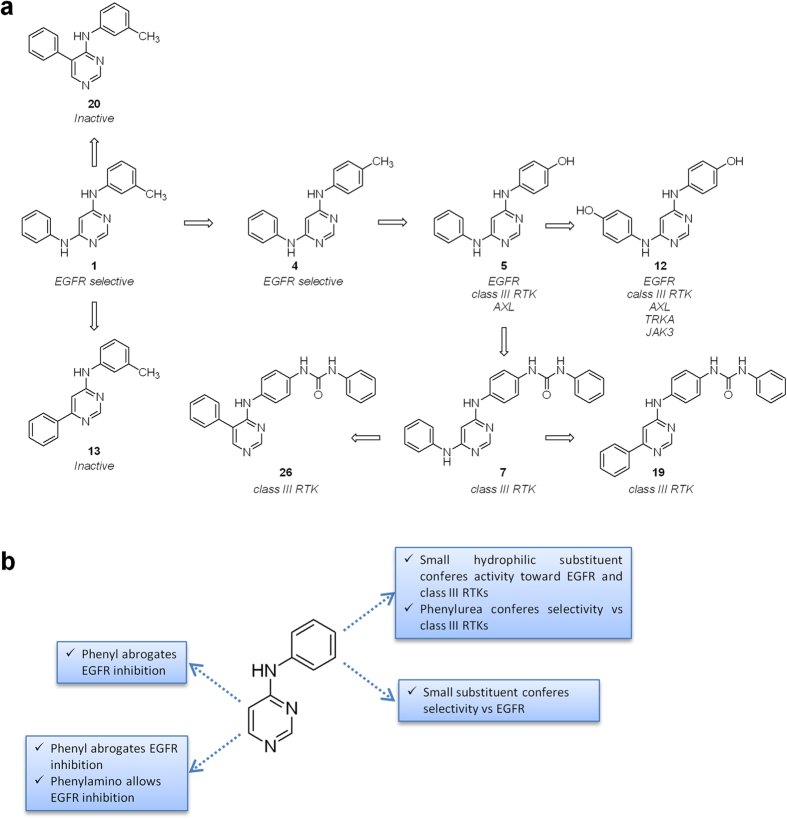
Structure activity relationships for 4-anilino compounds.(a) Selectivity profile of some selected compounds highlights the features required for selective EGFR, dual EGFR/class III RTKs or selective class III RTKs inhibition. (b) Schematic representation of main structure activity relationships with respect to 4-anilinopyrimidine core.